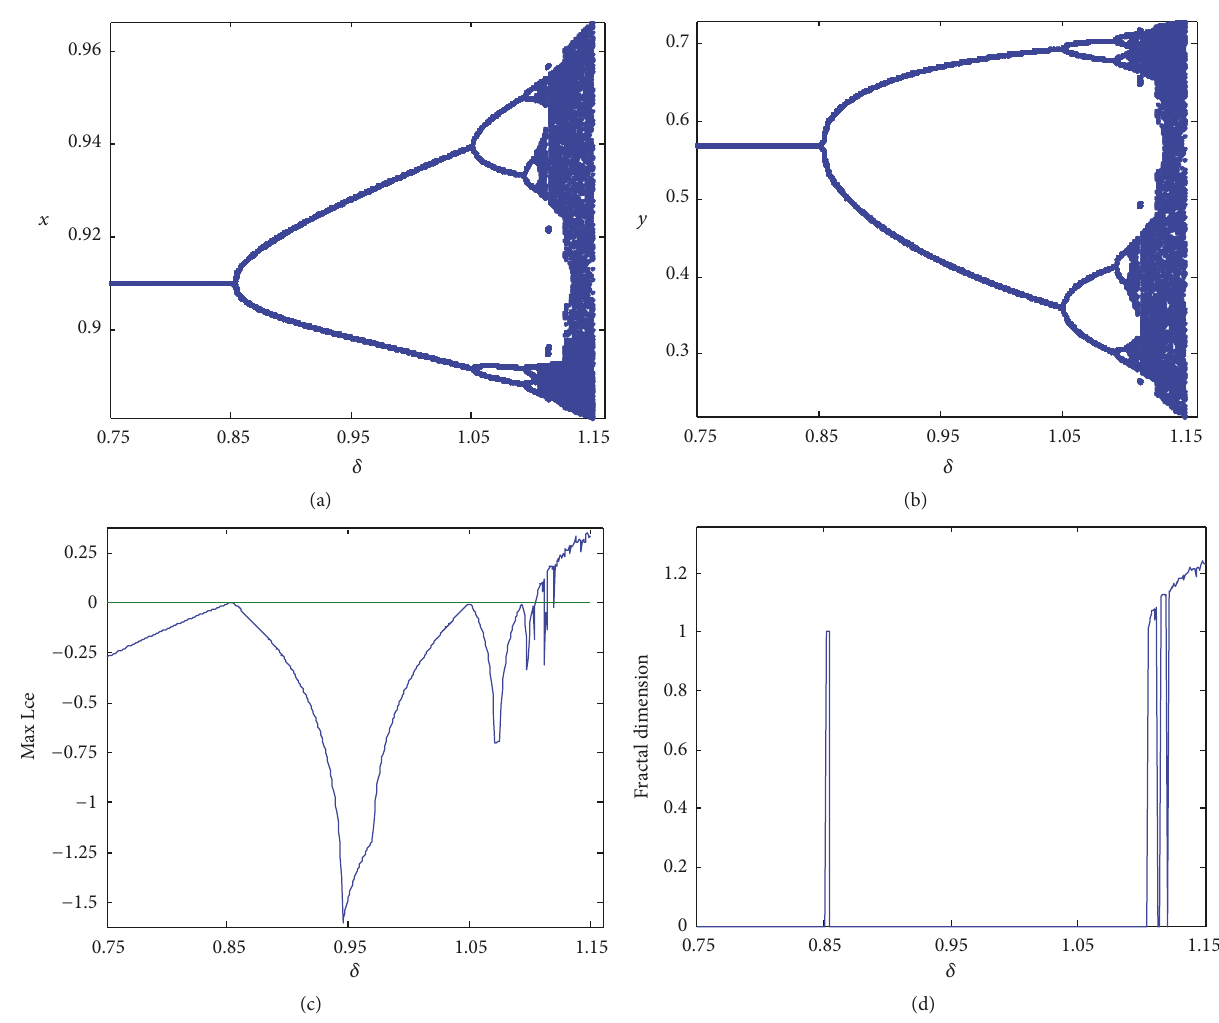
Figure 1: Flip bifurcation and Lyapunov exponent of system (4) . (a) Bifurcation for prey, (b) bifurcation for predator, (c) maximum Lyapunov exponents related to (a-b), and (d) fractal dimension corresponding to (a). Initial value (𝑥 0 ,𝑦 0 ) = (0.9,0.56) .